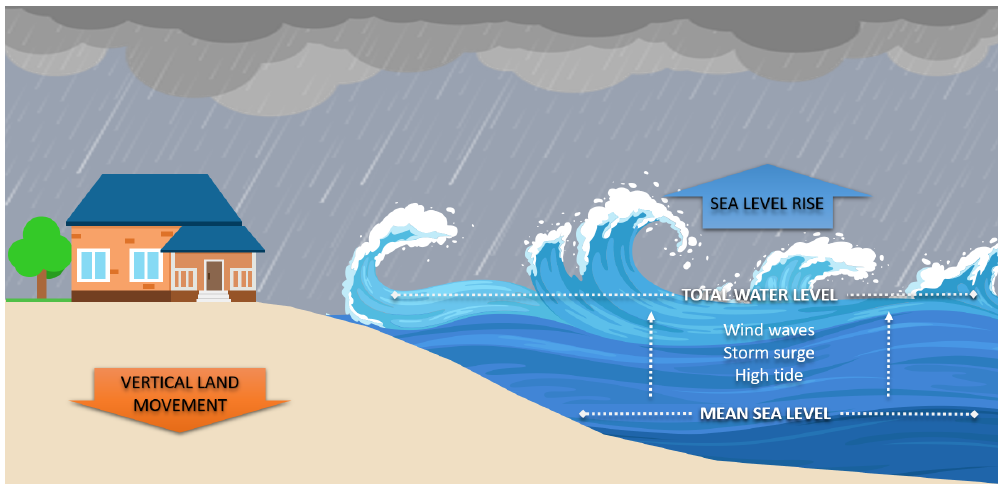
Figure 2. Components of the analysis for extreme sea level events: total water level is the sum of the maximum tide, storm surge and wind waves over mean sea level. Vertical land movement and sea level rise affect the mean sea level on the long